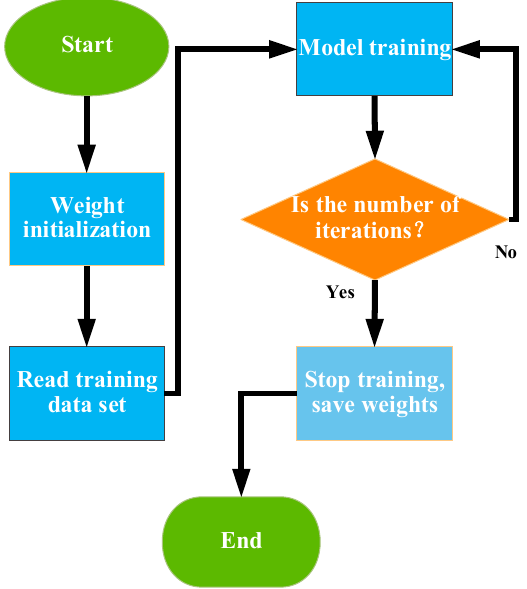
Figure 11. The entire model training process.